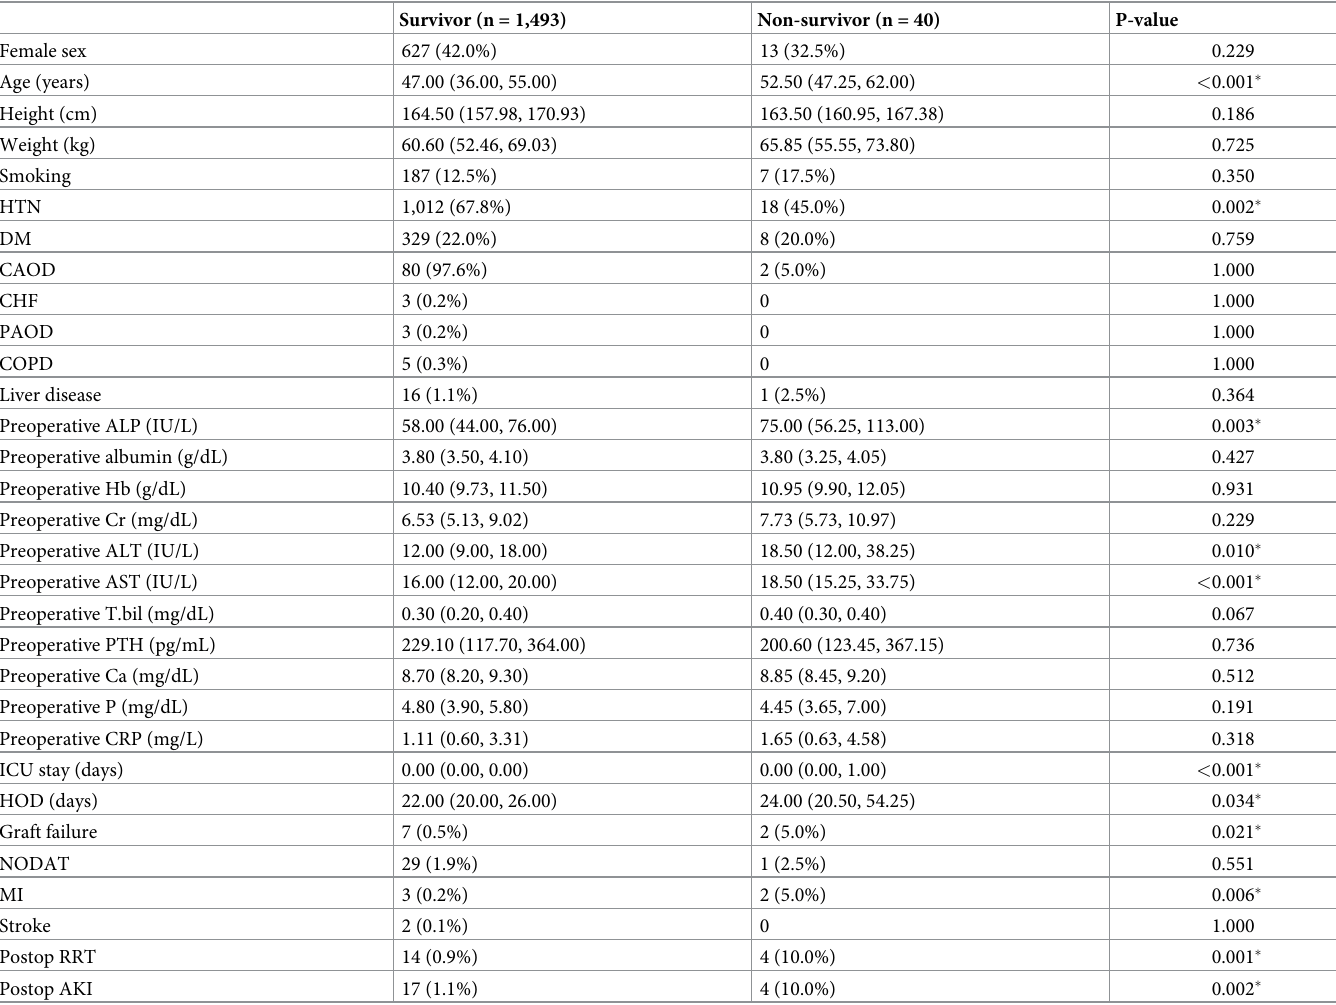
Table 4. Baseline characteristics and outcome variables of patients stratified based on 3-year